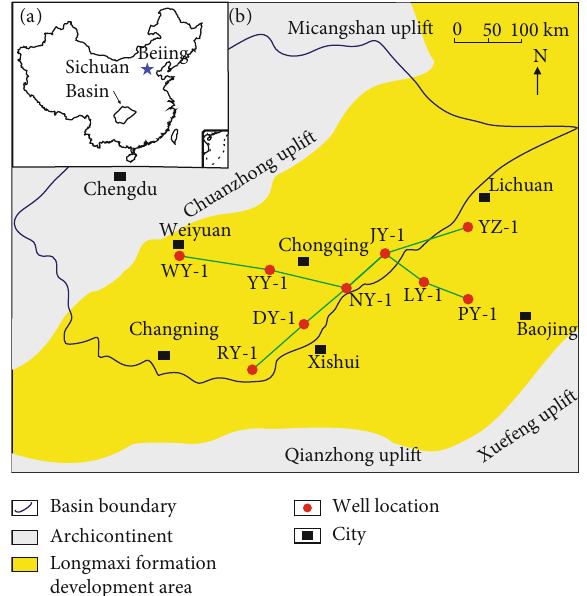
Figure 1: Tectonic setting and location of the southeast Sichuan Basin. (a) Location of the Sichuan Basin in China. (b) Tectonic setting of the southeast Sichuan